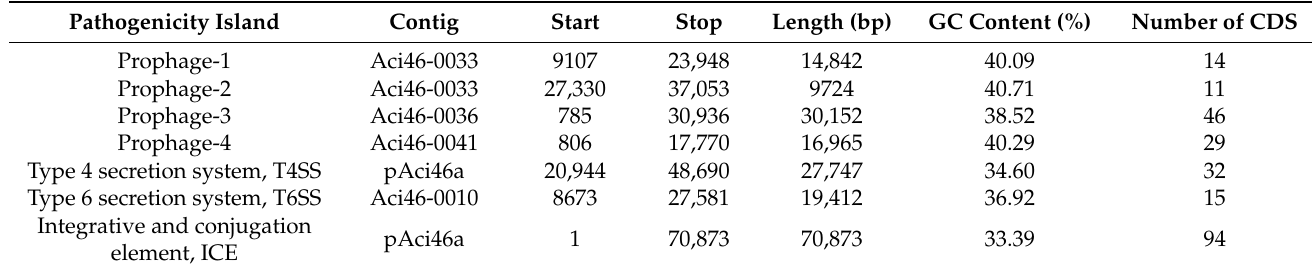
Table 4. Predicted pathogenicity islands in WGS of A. baumannii